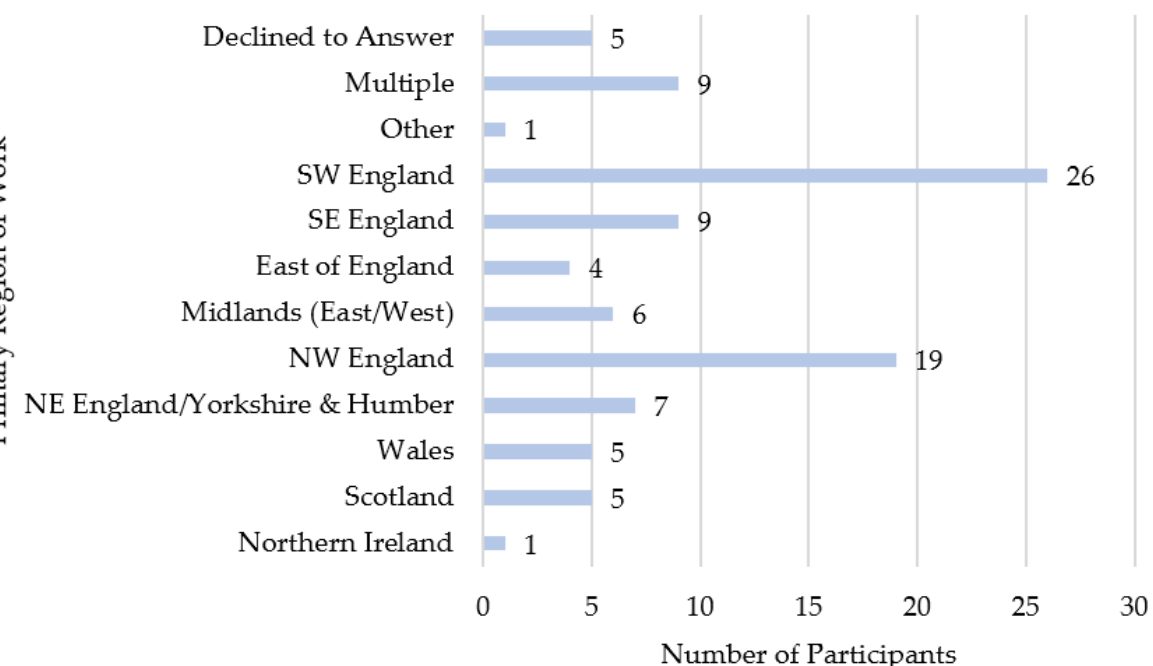
Figure 1. Participants’ primary region of work. NE = North East. NW = North West. SE = South East. SW = South West. For a map of UK regions, please refer to the Office for National Statistics website: https://geoportal.statistics.gov.uk/search?collection=Document&sort=name&tags=all(MAP_RGN) (accessed on 13 April 2021).